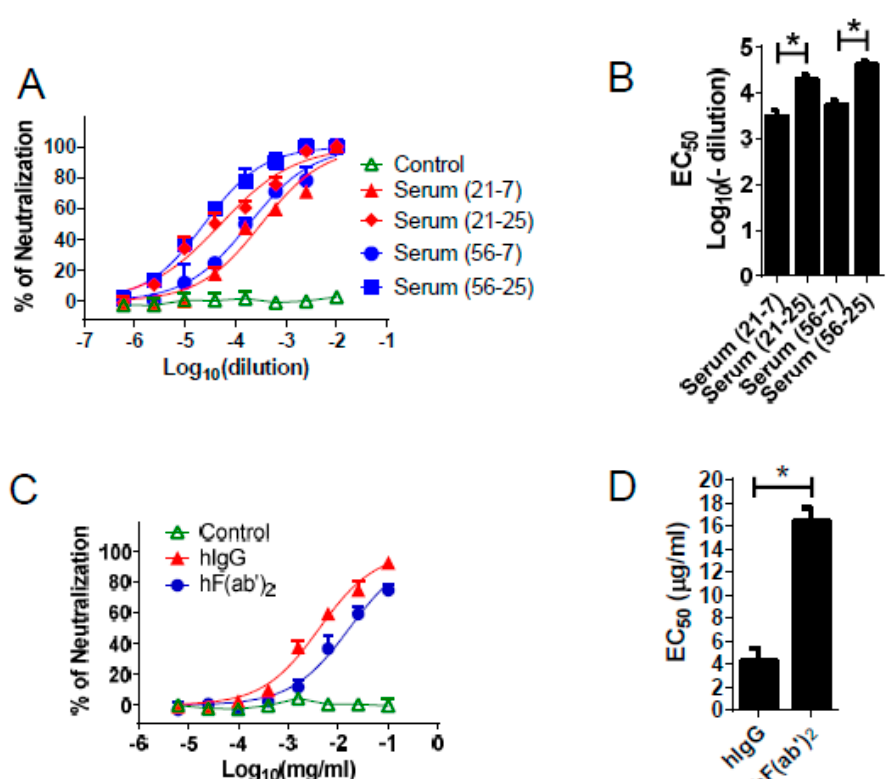
Figure 3. Neutralization assay for WNV using immune horse serum, purified IgG, and F(ab ′ ) 2 in vitro. The “21” and “56” are the horse ID numbers. The “21–7”, “56–7” and the “21–25”, “56–25” represent the sera that were collected after the fourth or fifth immunization, respectively. ( A , B ) Serum or ( C , D ) antibody samples from “56–25” were serially diluted in Dulbecco’s modified Eagle medium (DMEM) and mixed 1:1 with 80 PFU (Plaque Forming Unit) WNV. After a 1-h incubation at 37 °C, the mixture was added to Vero cells for an additional 1 h. After absorption, the cells were then overlaid with 1.2% agarose. After a further incubation for 3 days, the agarose plugs were removed. The plaques were visualized by 0.1% crystal violet staining; ( B ) The dilutions; and ( D ) Concentrations for 50% of the maximal neutralizing effect are shown. * p < 0.05. Normal horse IgG was used as the control.